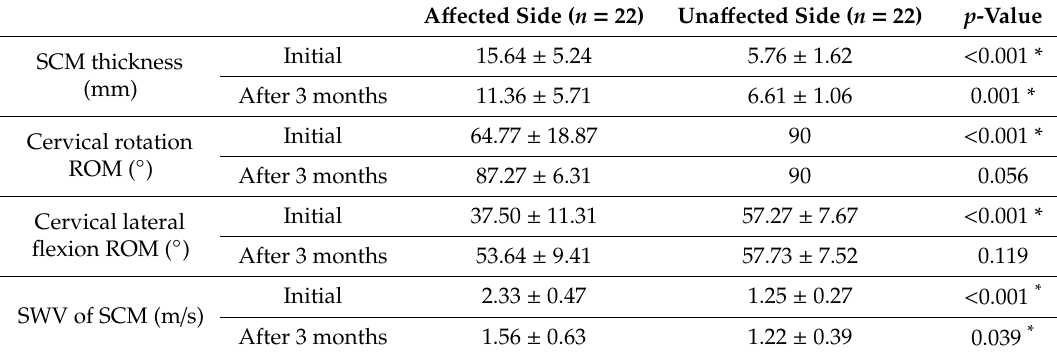
Table 2. Thickness, cervical range of motion, and shear-wave velocity of bilateral sternocleidomastoid muscles comparing the a ff ected and una ff ected side at initial evaluation and follow-up. A ff ected Side ( n = 22) Una ff ected Side ( n =